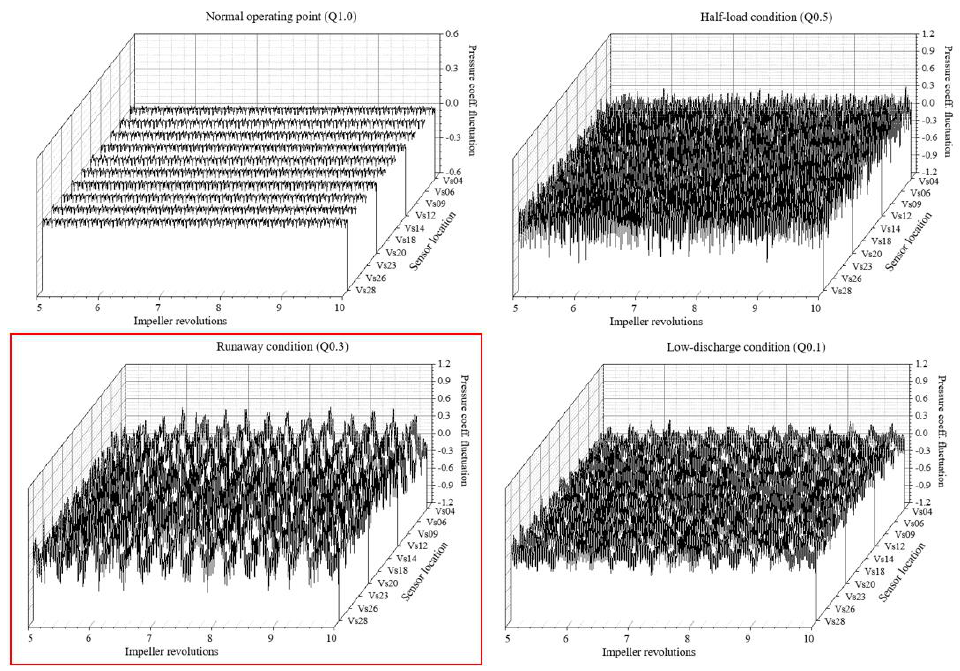
Figure 12. Time histories of pressure fluctuations at all monitoring points in the vaneless space under the normal and transition regions.